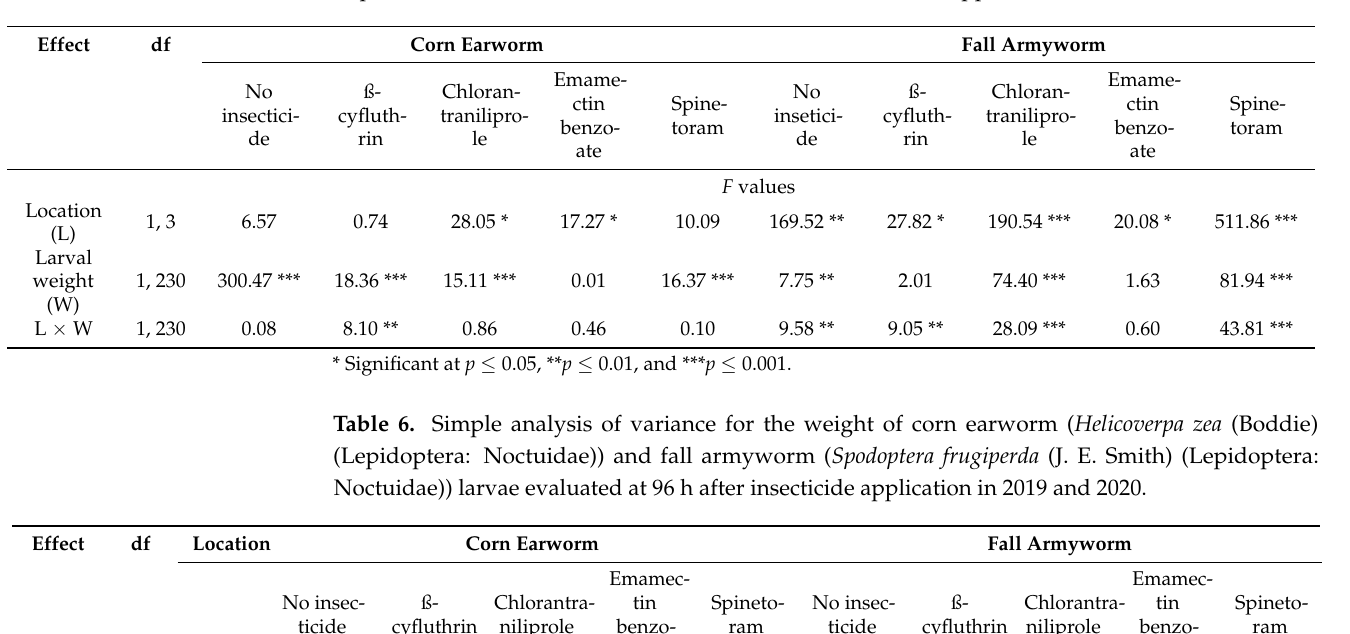
Table 4. Combined analysis of variance for the percentages of mortality of corn earworm ( Helicov- erpa zea (Boddie) (Lepidoptera: Noctuidae)) and fall armyworm ( Spodoptera frugiperda (J. E. Smith) (Lepidoptera: Noctuidae)) larvae evaluated at 96 h after insecticide application in 2019 and 2020. Effect df Corn Earworm Fall Armyworm F values Location (L) 1, 3 20.11 * 9.29 Treatment (T) 4, 24 47.07 *** 157.58 *** L × T 4, 24 12.69 ***